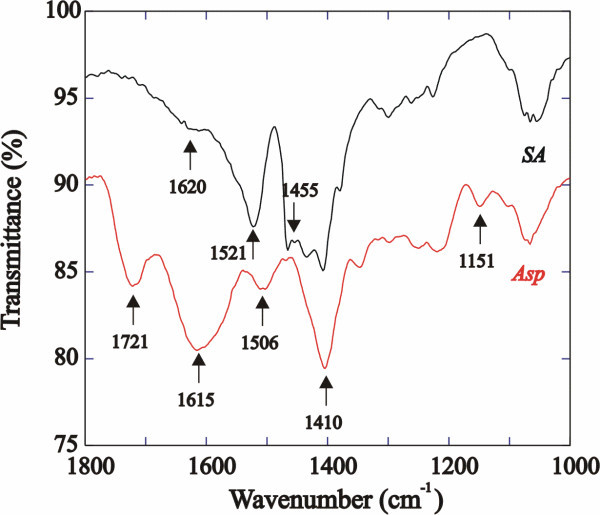
Solid-state ATR-FTIR spectra of SA-coated (top) and Asp-coated (bottom) TiO2 nanoparticles.